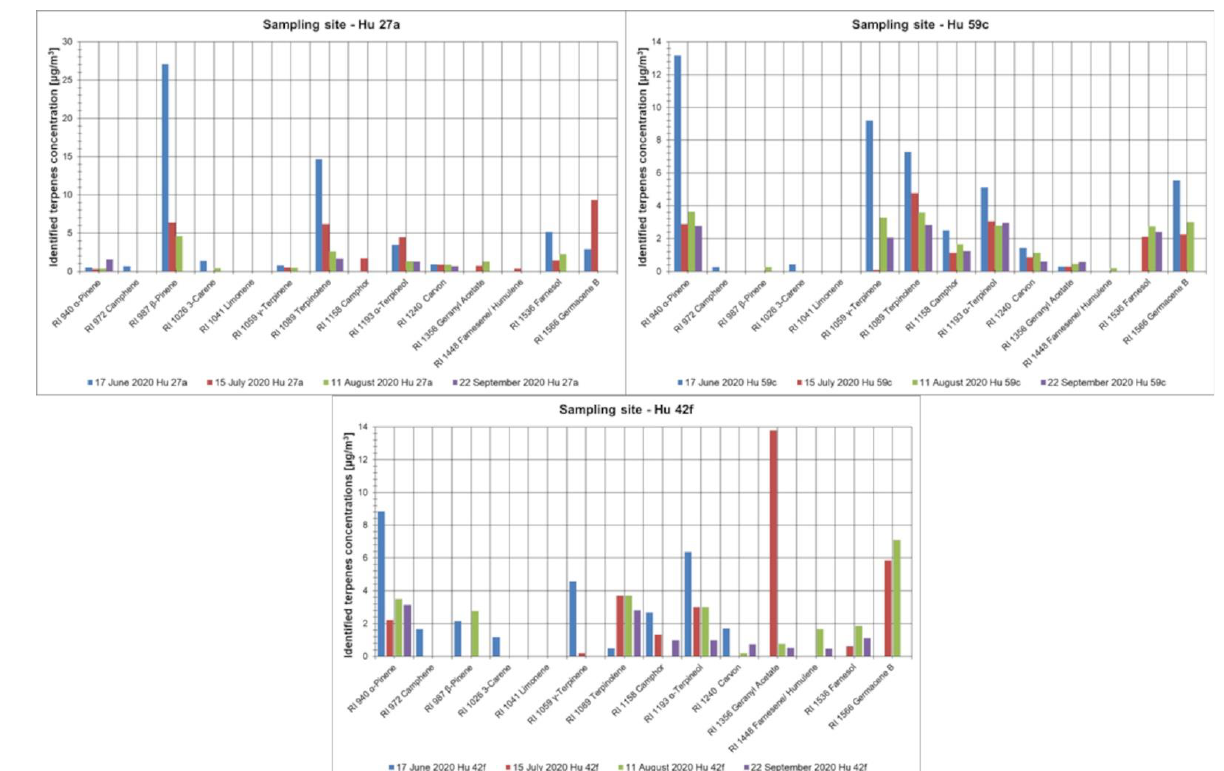
Figure A1. Distribution of concentrations of identified terpenes and terpenoids in atmospheric air over the Hucisko area for all measurement campaigns.